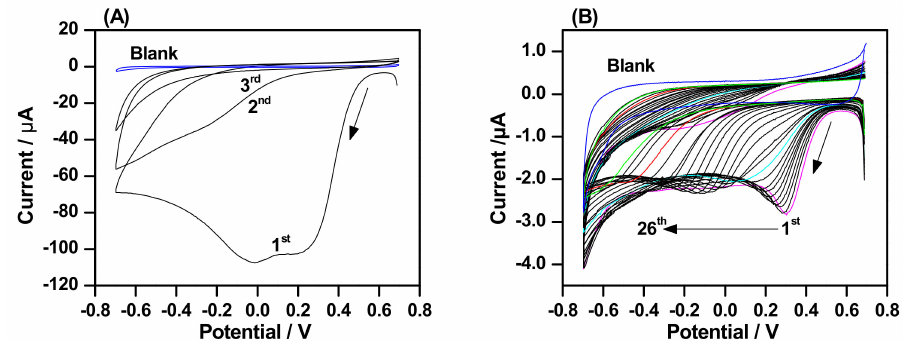
Figure 1. Cyclic voltammetry (CV) of blank, 50 mmol / L NBu 4 BF 4 + acetonitrile (ACN) (blue line) and 4-carboxybenzenediazonium (4-CBD): ( A ) 2.50 mmol / L for 3 cycles (black line); ( B ) 0.15 mmol / L for 26 cycles (black and colored lines): 1st cycle (magenta), 10th cycle (cyan), 23rd cycle (red) and 26th cycle (green). Scan rate of 0.10 V.s − 1 ; arrow shows the direction of scan.